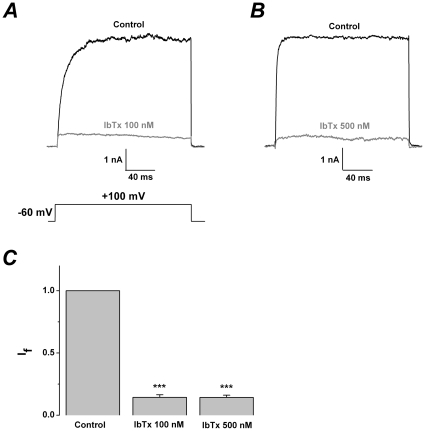
Characterization of gBK expression in U251 cells.(A) Representative whole cell current traces from U251 cells before and after the application of iberiotoxin (IbTx) 100 nM and 500 nM. The holding voltage was −60 mV and the currents were elicited by a pulse of +100 mV with 150 nM free Ca2+ in the pipette solution. (B) Statistics analysis of iberiotoxin-sensitive gBK channels in U251 cells as describe in A. Plot of the fraction of unblocked current (If, see “Data analysis”) versus the iberiotoxin concentration. Each point presents data from 6 cells. (n = 6). *** p<0.001.